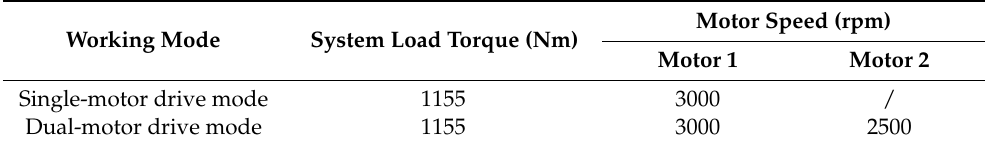
Table 5. Parameter of the system under steady-state